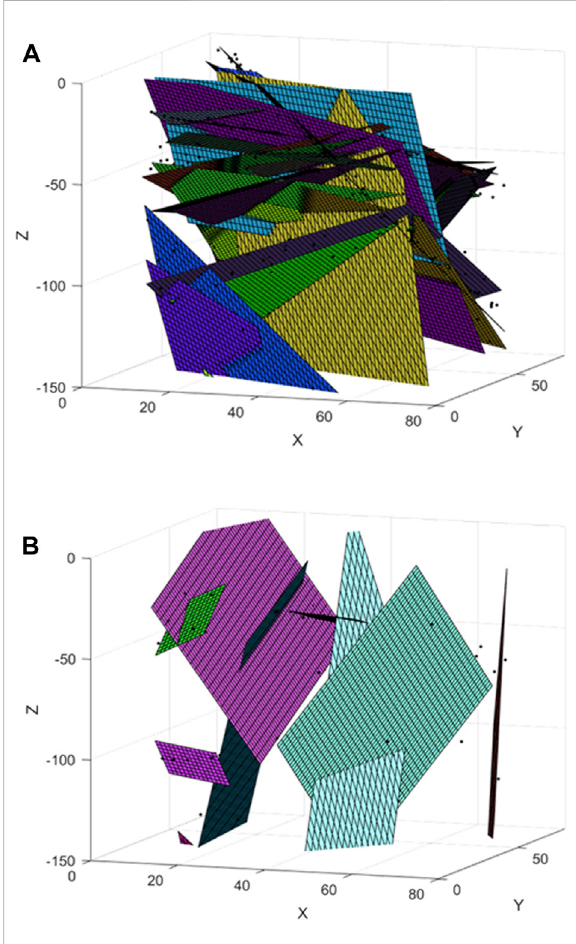
FIGURE 4 (A) Initial model created using the Random Sample Consensus (RANSAC) method with 100 randomly generated planes. (B) Results of Delaunay triangulation application to the synthetic data shown in Figure 3B.